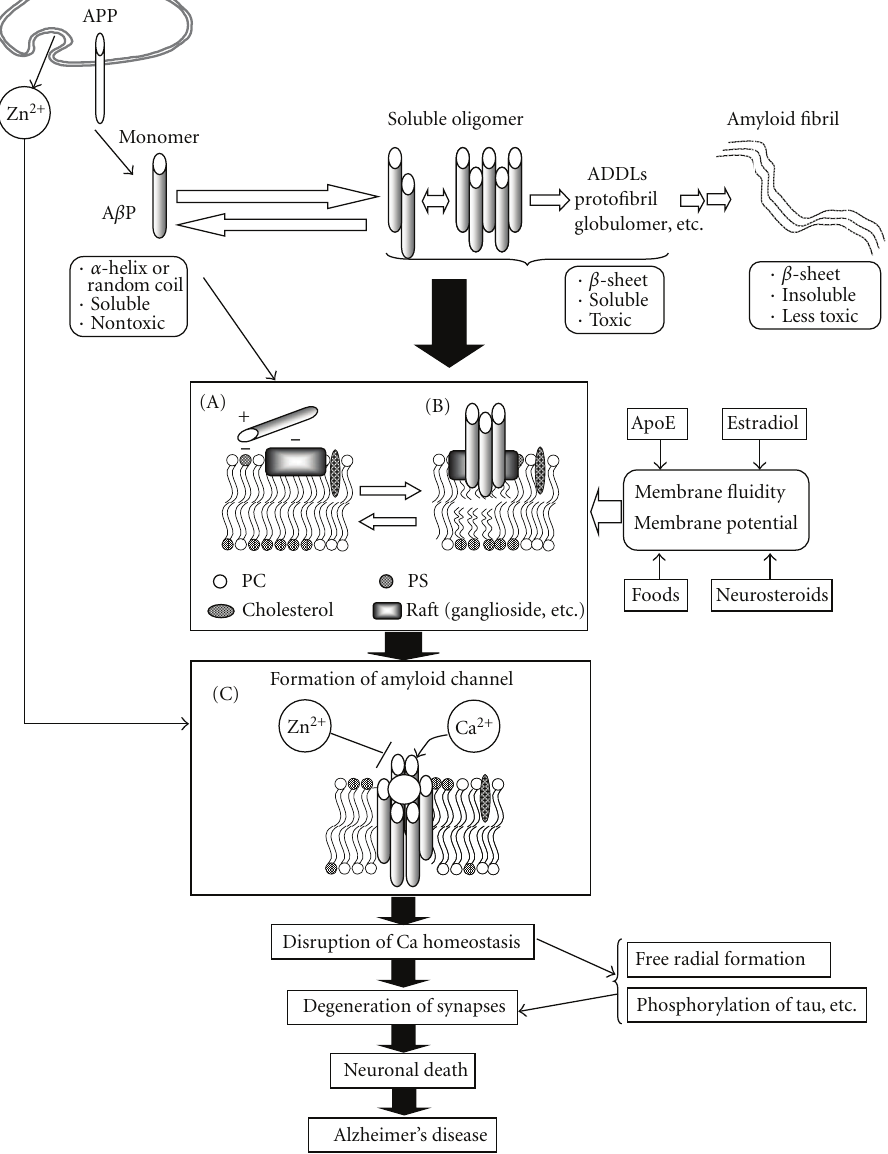
Figure 7: Hypothesis concerning amyloidchannels and pathogenesis of Alzheimer’s disease. A β Ps are secreted from APP in synapses, directly incorporated into membranes. The possible hypothetical scheme of the formation of oligomeric amyloid channels is depicted. Details are shown in the